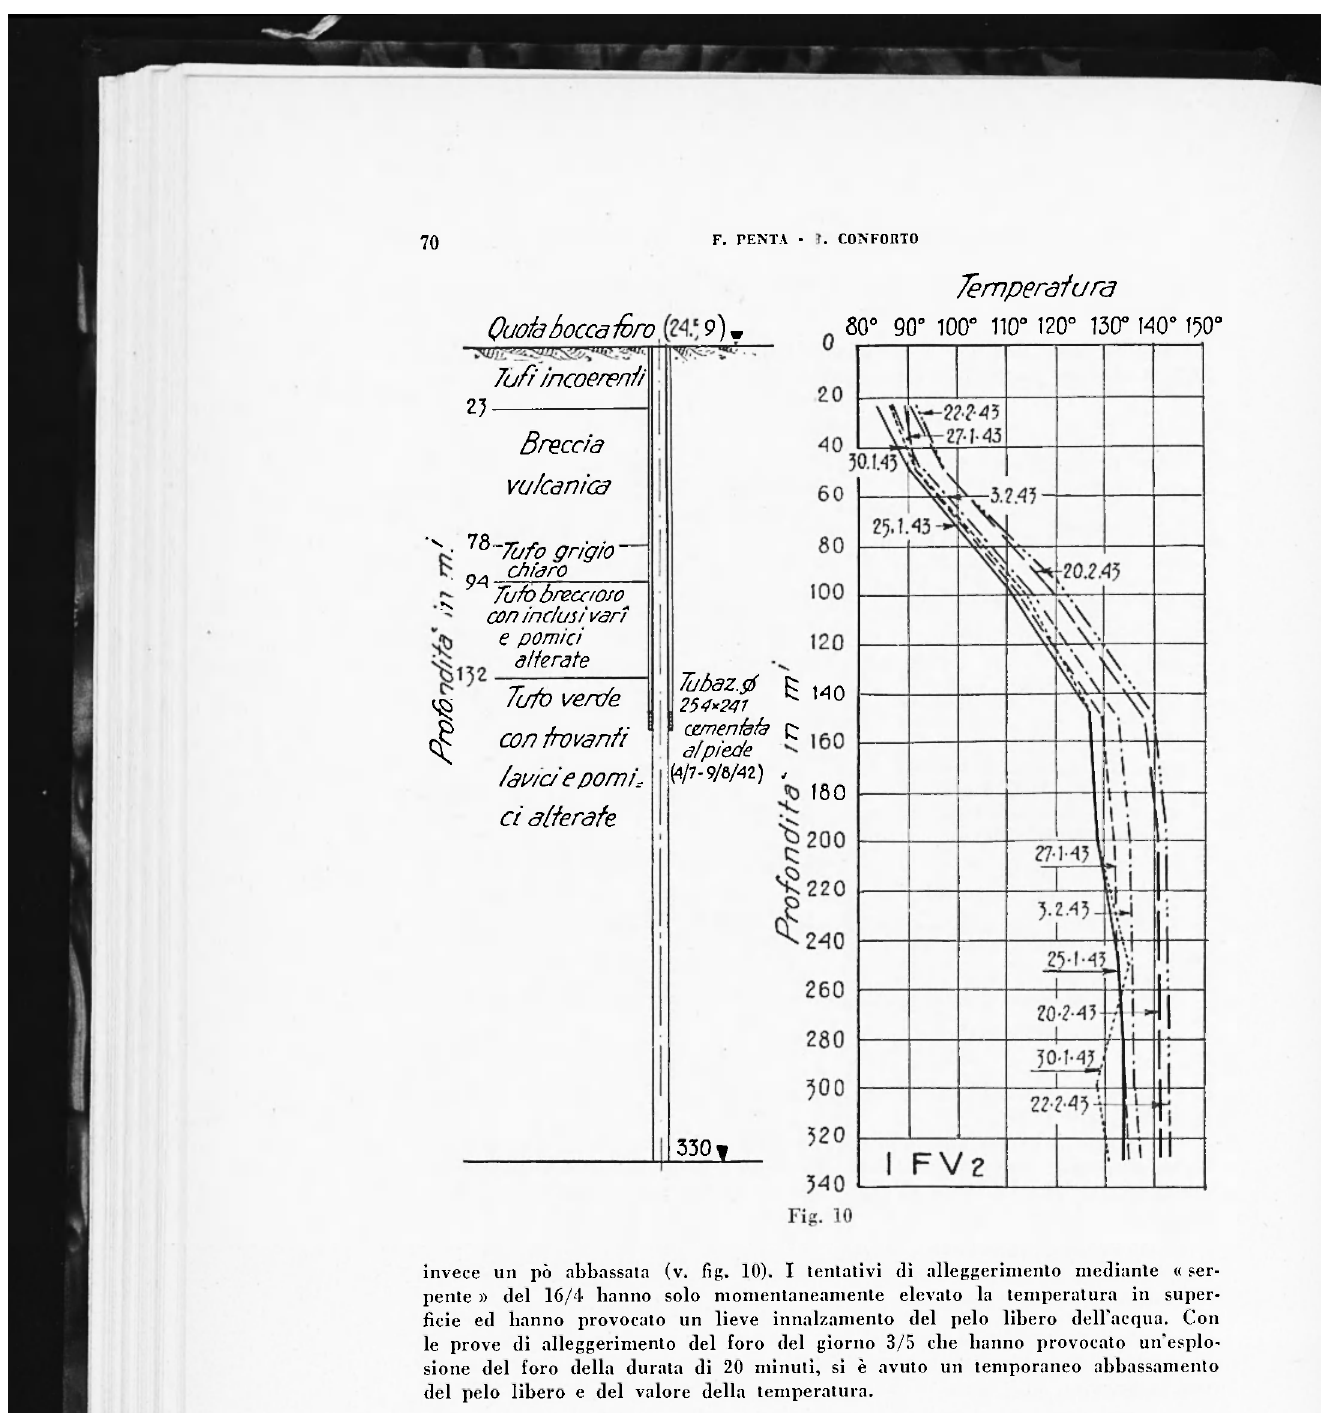
Fig. 12 - Foro IFV2, profondo m 330. Distribuzione della temperatura lungo la verticale del foro prima e dopo una « esplosione » artificialmente